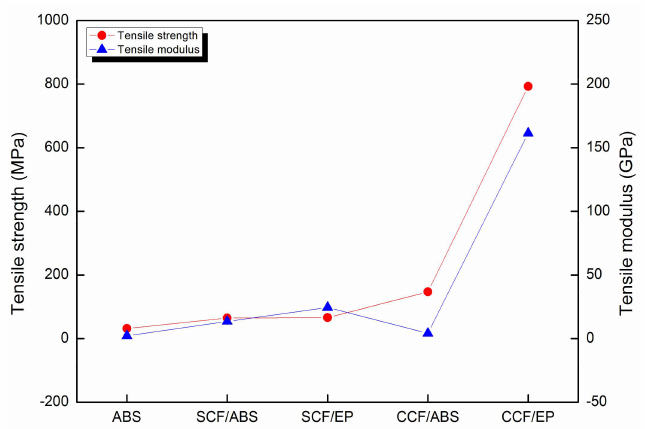
Figure 1. Performance evolution of 3D printing for di ff erent materials, including acrylonitrile butadiene styrene (ABS) [2], short carbon fiber (SCF) / ABS [10], SCF / epoxy resin (EP) [12], continuous carbon fiber (CCF) / ABS [13], and CCF / EP